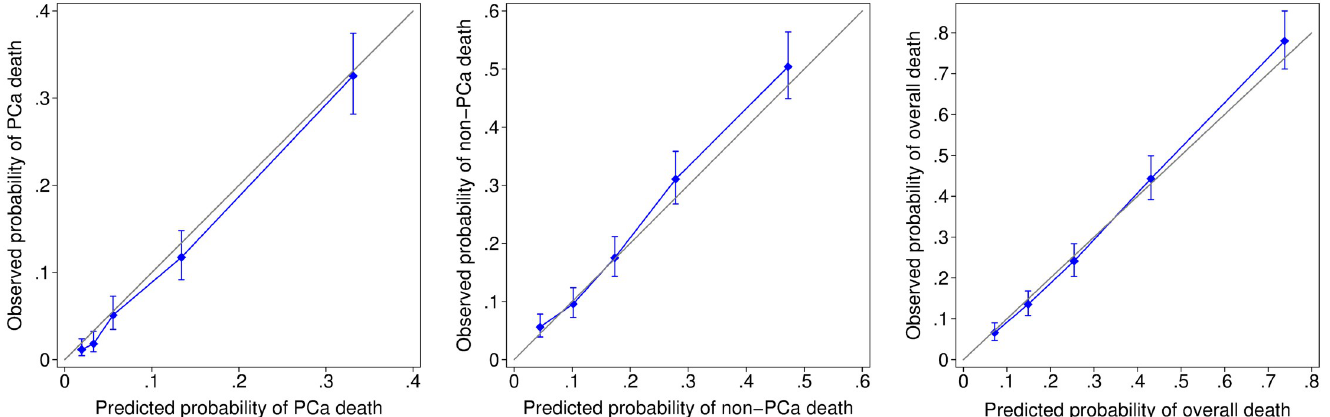
Fig 2. Calibration curves comparing observed and predicted probability of PCa (left), non-PCa (centre), and overall (right) deaths at 10 years, by quintile of risk, within the UK validation cohort. PCa, prostate cancer.